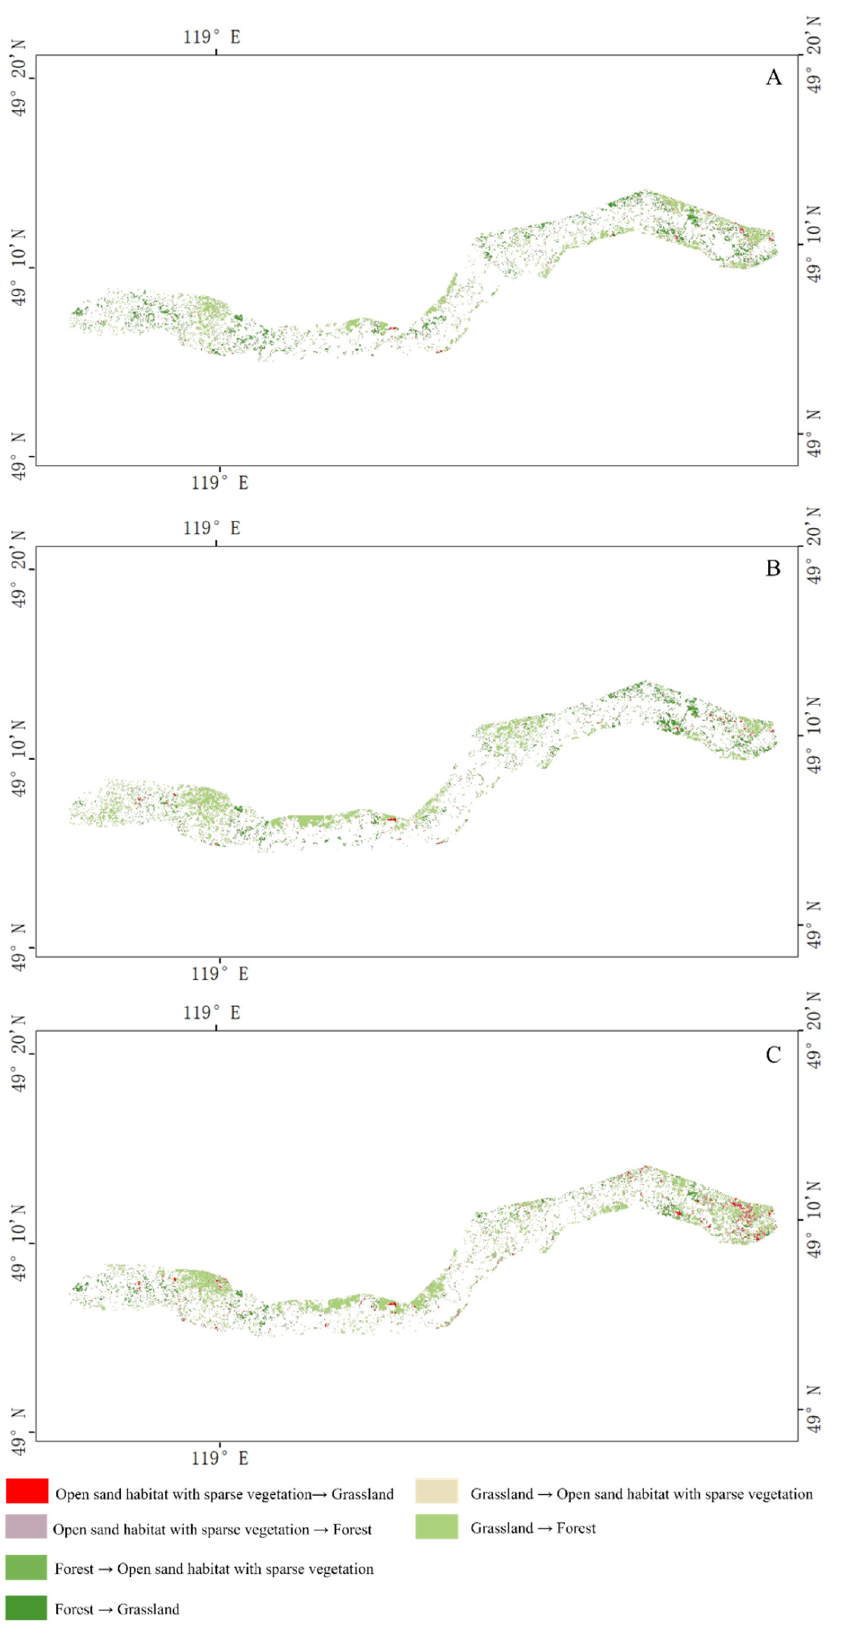
Figure 5. NDVI category changes occurring in the three time periods of ( A ) 1987–2019, ( B ) 2001–2019, and ( C ) 2010–2019.